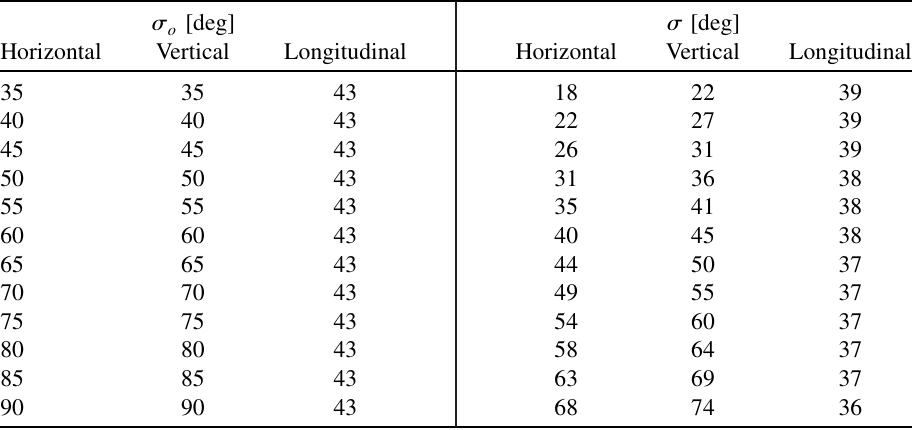
TABLE III. Horizontal, vertical, and longitudinal phase advances along the DTL in case of zero current (left) and of 7.1 mA of 40 Ar 10 þ (right) for an rms-equivalent KV-beam. The corresponding normalized 100% rms emittances are 0 : 12 = 0 : 23 mm mrad (horizontal/vertical) and 66 deg mrad (referring to 108 MHz and to relative momentum deviation).